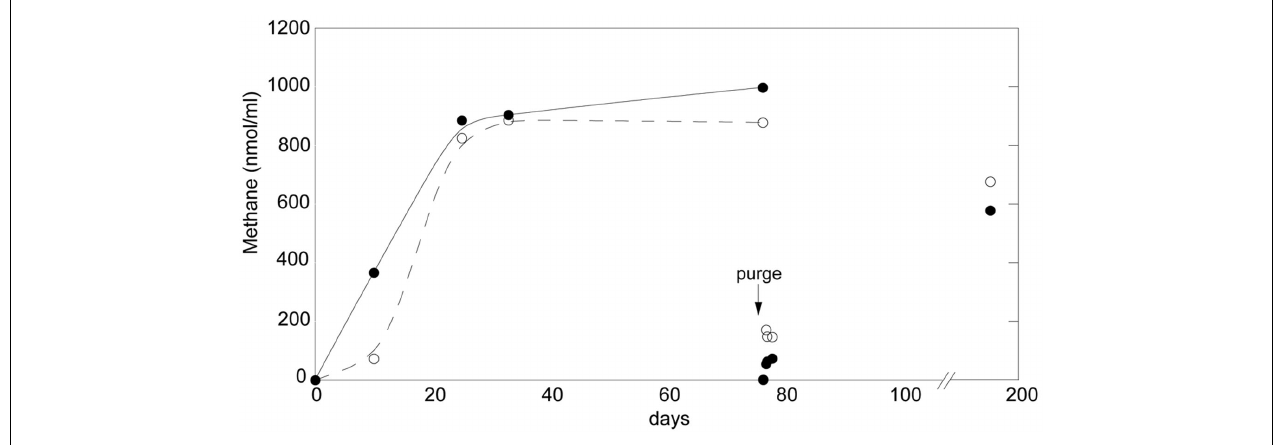
FIGURE 2 | Methane production by bromeliad catchment water. Methane increased within a few days and reached a plateau, by day ∼ 30, at ∼ 900nmolml − 1 CH = ∼ 22000ppm CH 4 in the headspace ( 4 ). Following a purge of the headspace with nitrogen, at day 76, methane production resumed, and was measured once more at day 192. Methane